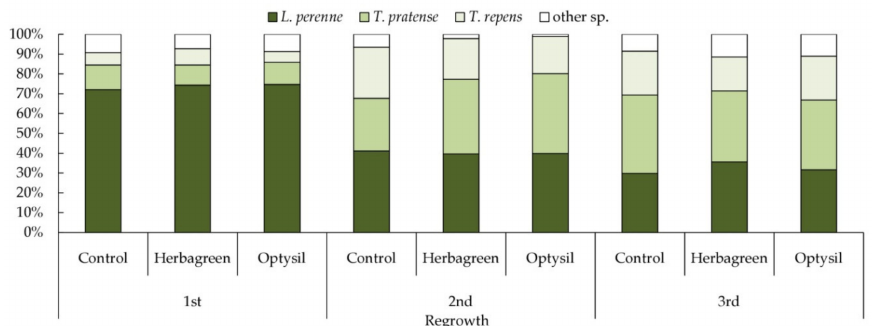
Figure 2. Botanical composition of grass–clover sward (%) in regrowths (1st, 2nd, 3rd) in the study period (mean 2015–2017).